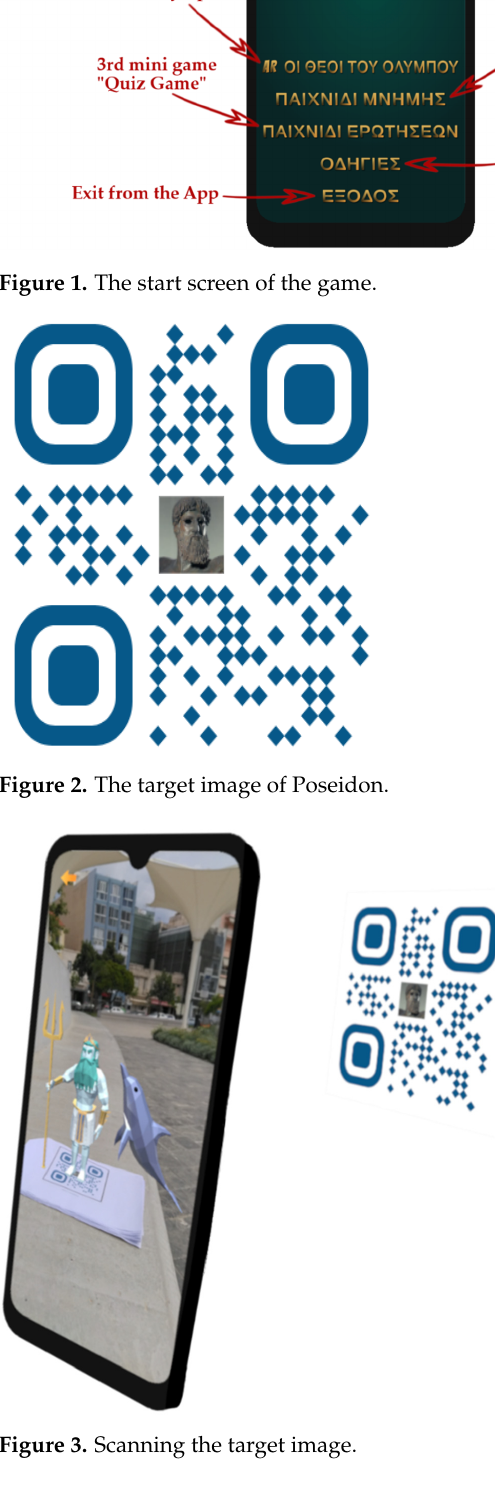
Figure 3. Scanning the target image.